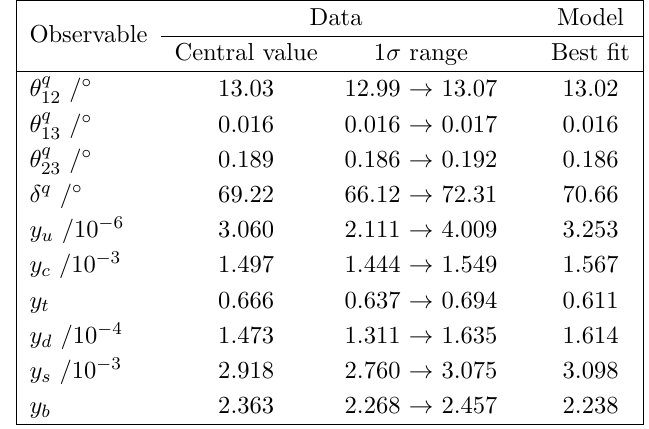
Table 4. Model predictions in the quark sector for tan (cid:12) = 20, M SUSY = 1 TeV and (cid:22) (cid:17) The observables are at the GUT scale. The quark contribution to the total (cid:31) 2 is 10.7.